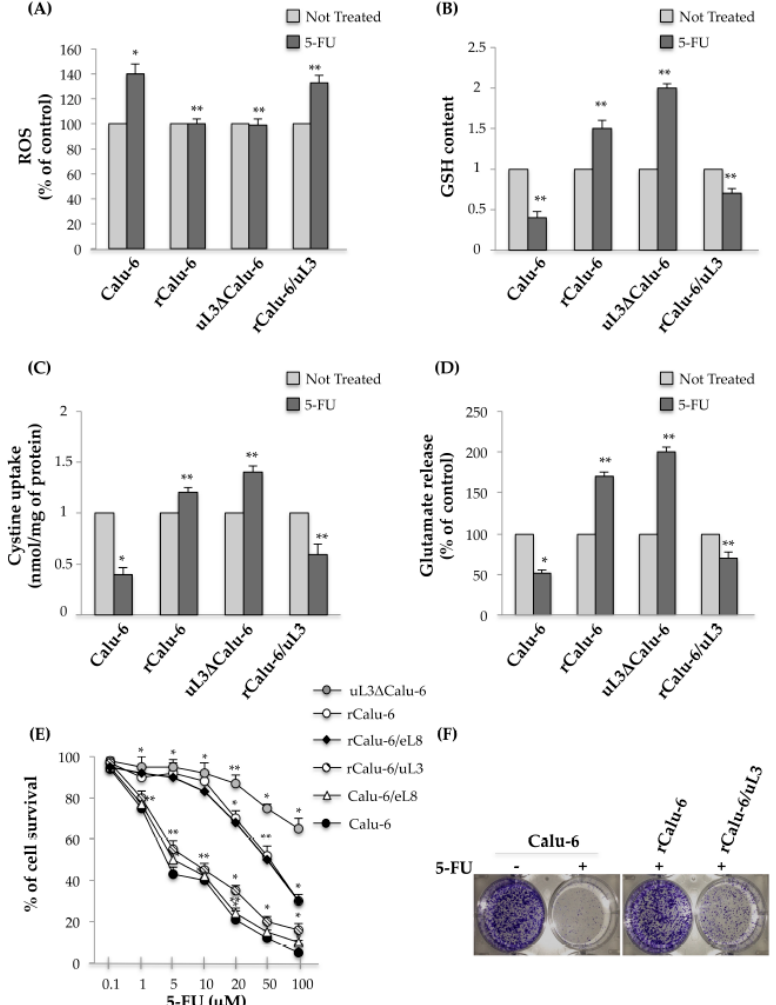
Figure 3. uL3 contributes to Reactive Oxygen Species (ROS) defense in rCalu-6 cells. ( A ) Histogram quantifying ROS production in indicated cell lines after treatment with 5-FU. ** p < 0.01, * p < 0.05 vs. respective untreated cells set at 1; ( B ) Glutathione (GSH) content in Calu-6 cells and derivative sublines after treatment with 5-FU. The quantification of signals is shown. ** p < 0.01, * p < 0.05 vs. respective untreated cells set at 1; ( C ) Changes in cystine uptake after incubation of indicated cells with 5-FU. ** p < 0.01, * p < 0.05 vs. respective untreated cells set at 1; ( D ) Evaluation of glutamate release in indicated cell lines after treatment with 5-FU. ** p < 0.01, * p < 0.05 vs. respective untreated cells set at 1; ( E ) uL3 Δ Calu-6, rCalu-6, rCalu-6/uL3, rCalu-6/eL8, Calu-6/eL8 and Calu-6 cells were cultured with increasing concentrations of 5-FU for 48 h and cell growth was assessed by SRB colorimetric assay. Cell growth was expressed as the percentage of control for each time point. Ectopic expression of uL3 (rCalu-6/uL3 cells) abolished resistance to 5-FU. ** p < 0.01, * p < 0.05 vs. Calu 6 cells; ( F ) Representative image of the clonogenic analysis for cell proliferation of Calu-6, rCalu-6, and rCalu-6/uL3 after treatment with 10 µM 5-FU for 48 h.